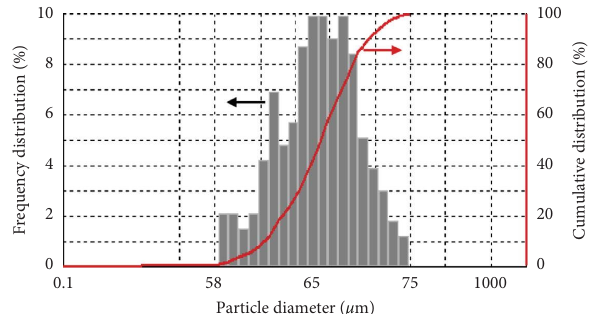
Figure 3: Particle size distribution of a coal dust sample.